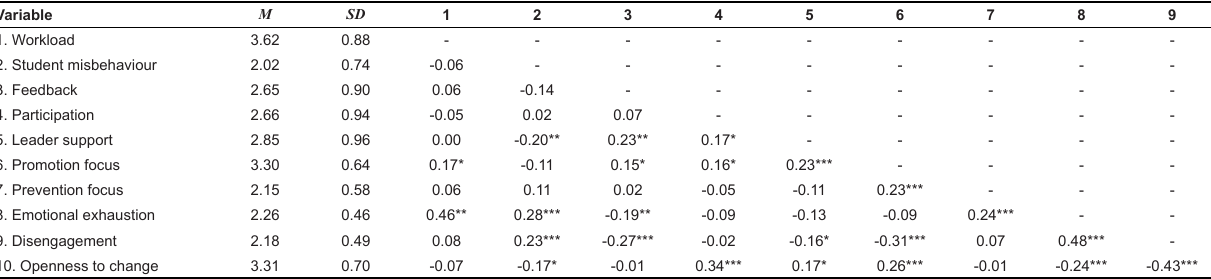
TABLE 2 Means, standard deviations and correlations between the variables in Sample 2 ( N = 189)